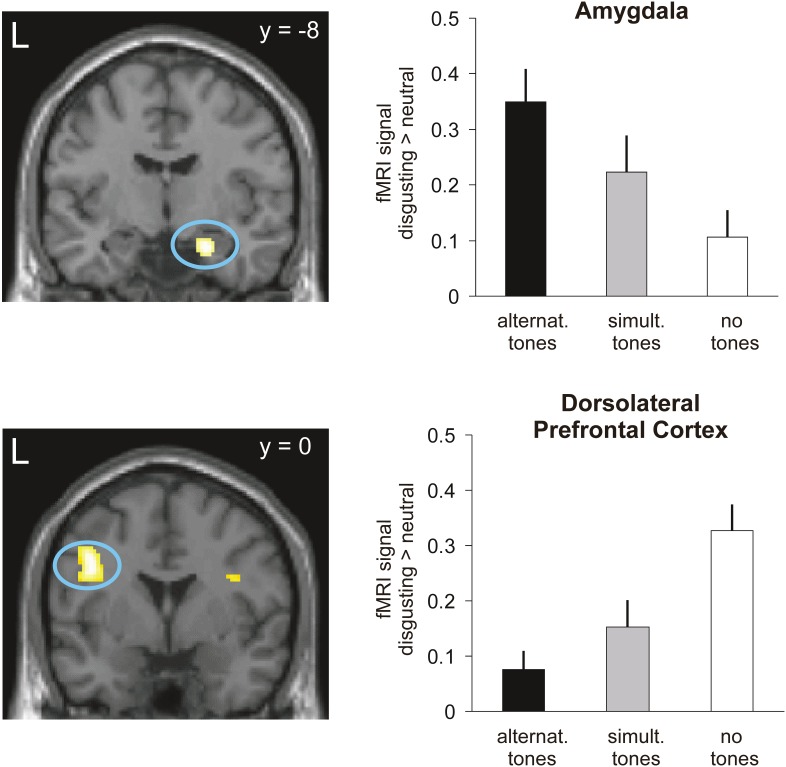
fMRI results: interaction of emotional picture presentation with type of auditory stimulation.Results of the interaction analysis of condition (visual disgusting vs. neutral stimulation) and auditory stimulation (alternating/simultaneous/no tones). Upper part – increased amygdala activation under alternating tones. Lower part – decreased dorsolateral prefrontal activation under alternating tones Plots show the mean signal of all significant voxels in the respective region and standard errors. For demonstration purposes, brain activations are shown at p<0.005 uncorrected.